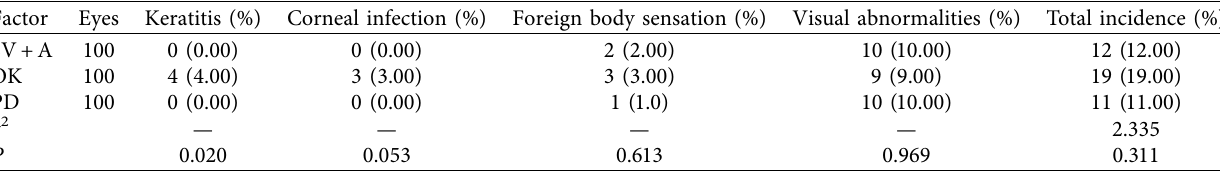
Table 5: Comparison of complications between the SV +A, OK, and PD